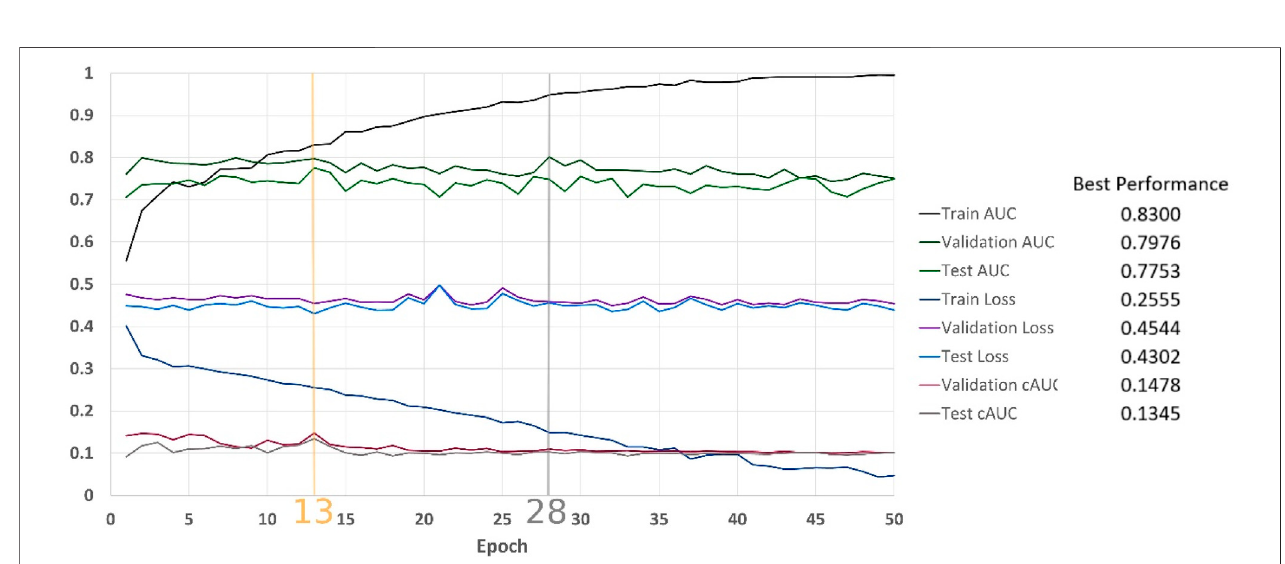
FIGURE 9 | Classi fi cation results on the PCa